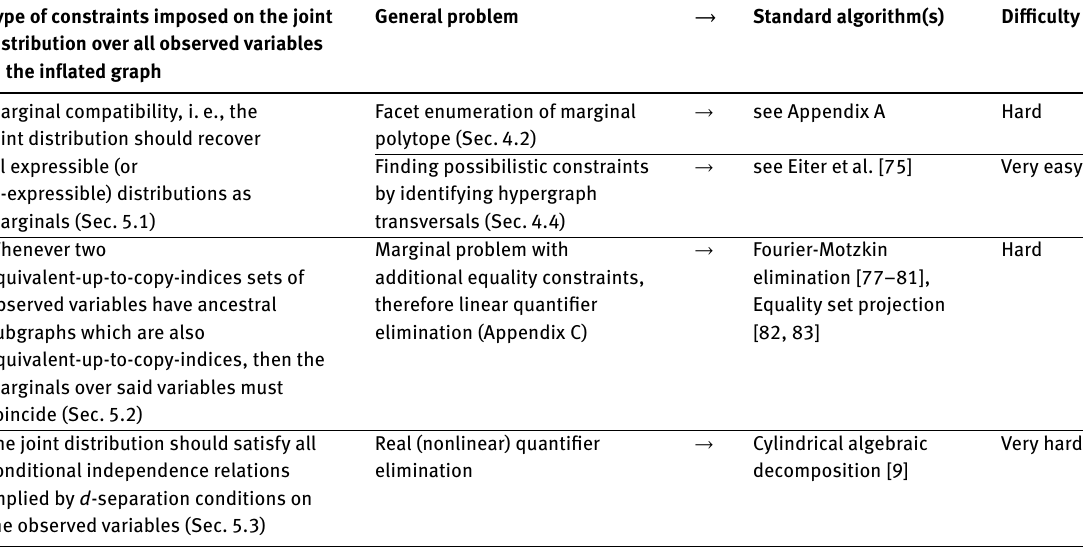
Table 1: A comparison of different approaches for deriving constraints on compatibility at the level of the inflated causal struc- ture, which then translate into constraints on compatibility at the level of the original causal